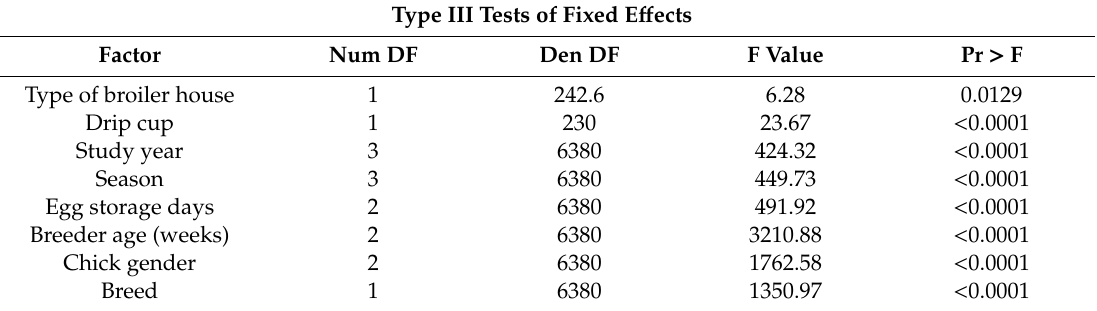
Table 2. The results from the generalized linear mixed model of the cumulative first-week mortality in the study of 2267 flocks in 104 farms with 253 houses (Spain, 2015–2018).